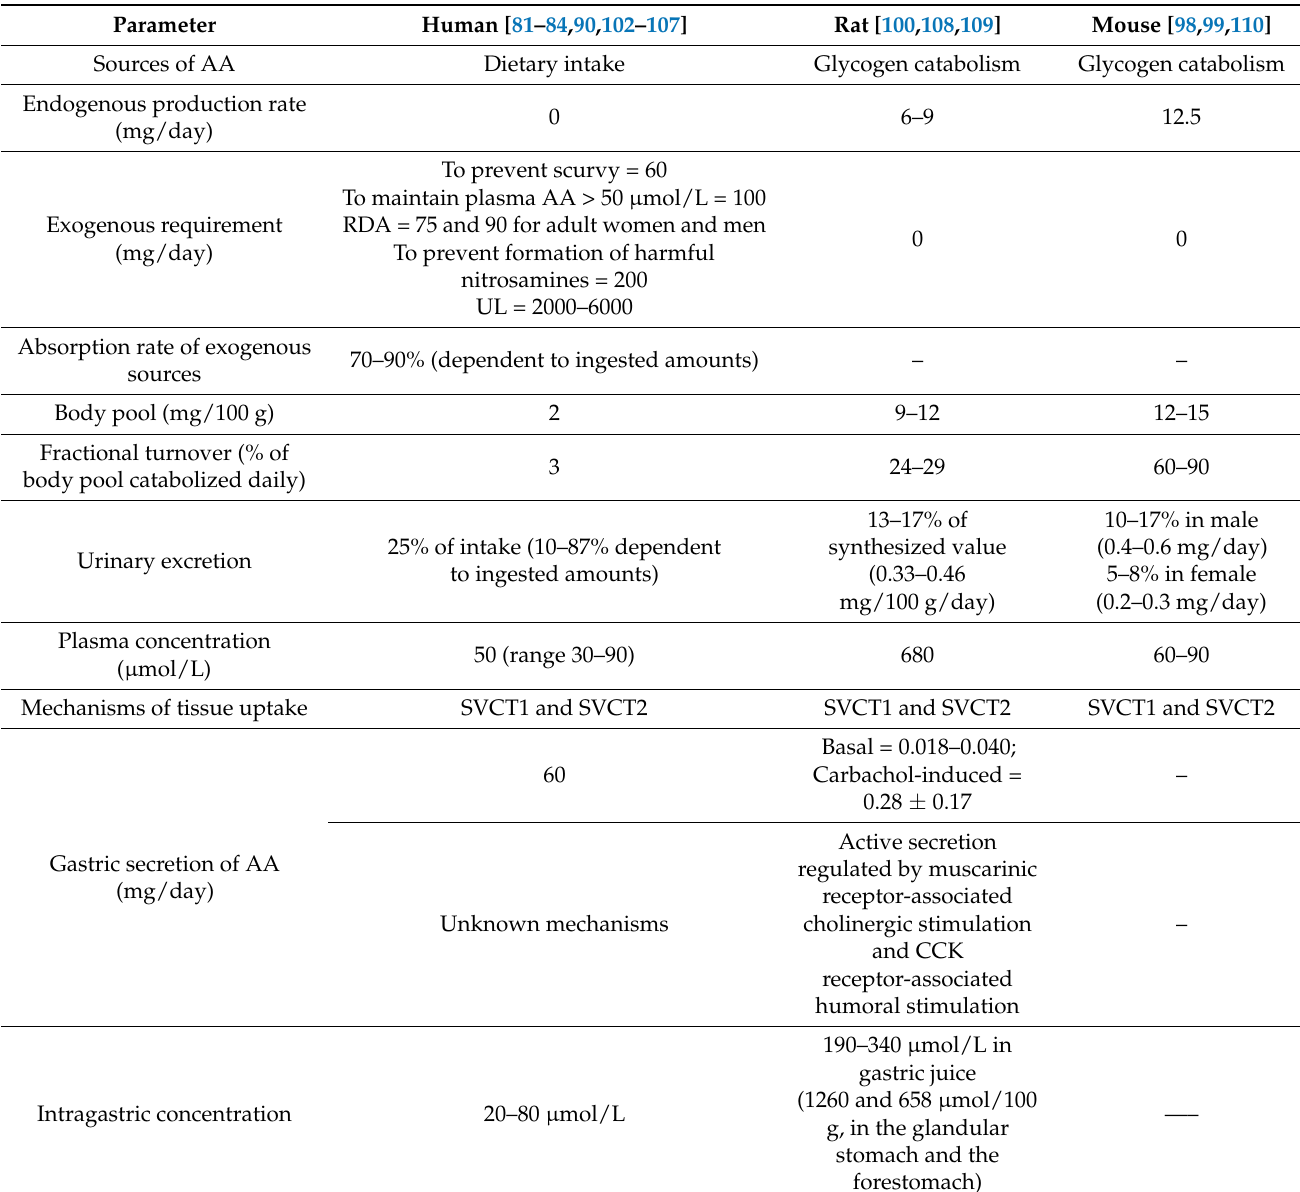
Table 3. Kinetic parameters of ascorbic acid (AA) metabolism between AA synthesizing and non-synthesizing species.